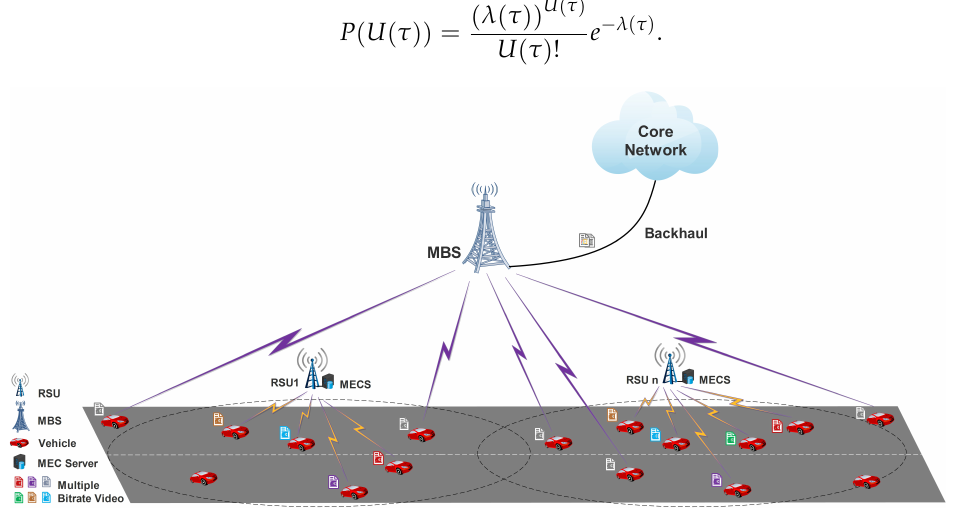
Figure 1. System